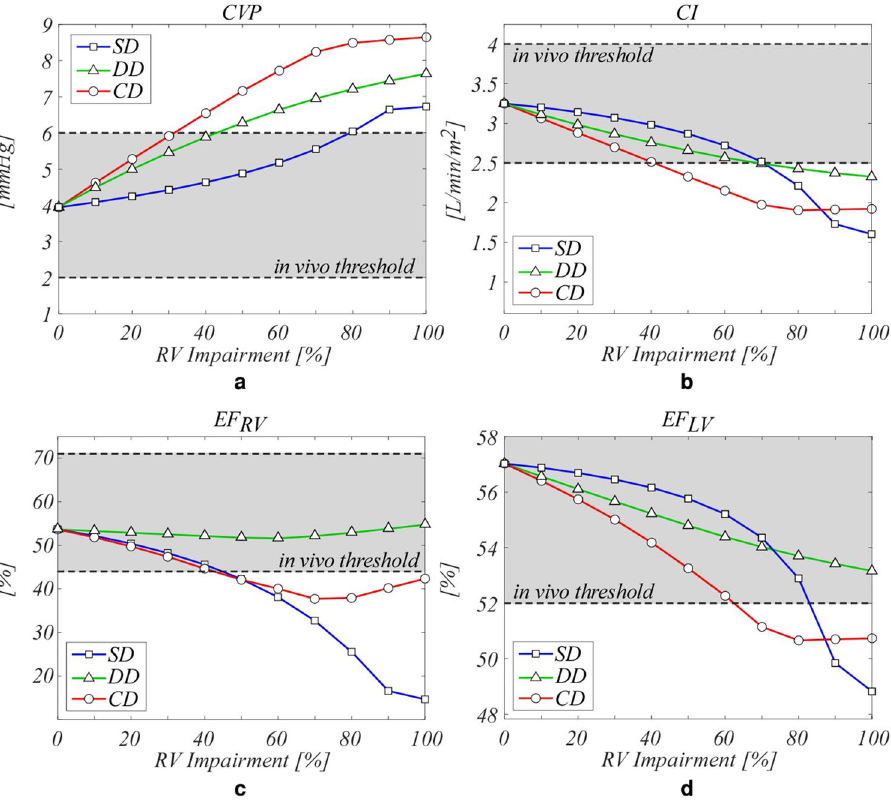
Figure 5. Comparison at various rates of impairment between the different types of dysfunction (symbols) and in vivo reference data (grey area) for a healthy subject. □ , systolic dysfunction, ∆, diastolic dysfunction, and ○ , combined systolic and diastolic dysfunction. ( a ) CVP, mean pressure in the central veins and in vivo data 53 , ( b ) CI, cardiac index and in vivo data 53 , and EF, ejection fraction for ( c ) right ventricle (RV) (EF RV ) and in vivo data 59 , and ( d ) left ventricle (LV) (EF LV ) and in vivo data 60 .